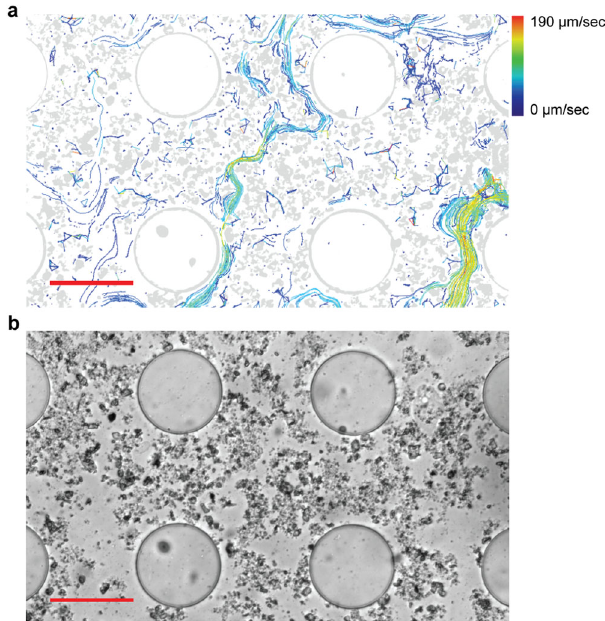
Fig. 5 Preferred water fl ow paths in the soil matrix within the chip, revealed by tracking of displaced particles. a Threshold image and tracked particle visualization of a 45 s long real-time movie sequence (ImageJ plug- in TrackMate version 3.8.0.; Supplementary Movie 17). Colors of the lines following the tracked paths indicate the mean velocity of the particles. The large round structures are pillars of the chip, smaller particles are soil minerals that were dragged into the chip. The recorded water fl ow was caused by drying of the chip through the adjacent soil layer. b Original bright- fi eld image (Supplementary Movie 18), recorded from an initially air- fi lled chip buried in soil of Expt. 1. Scale bars = 100 µ m ( a , b